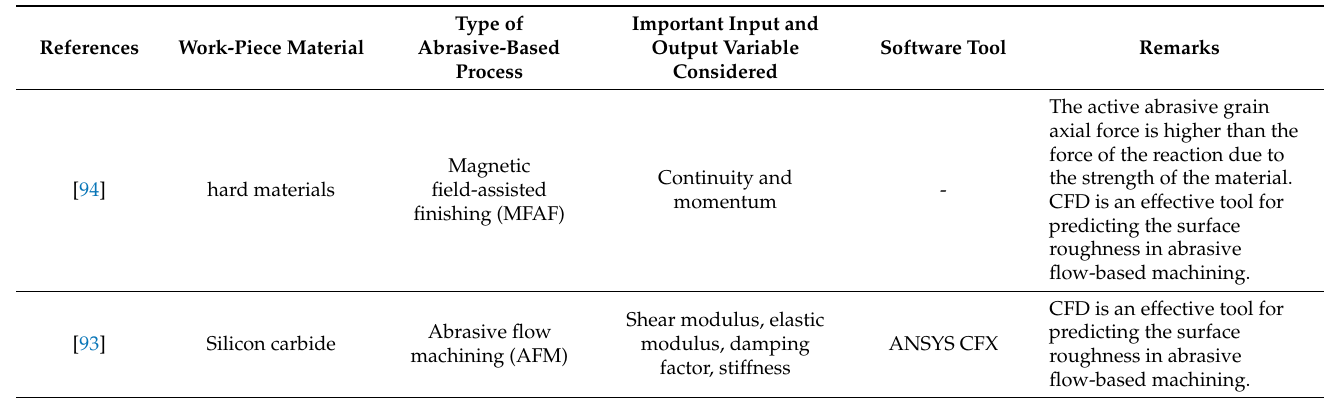
Table 6. Summary table of CFD-based modeling and simulation of the loose abrasive-based